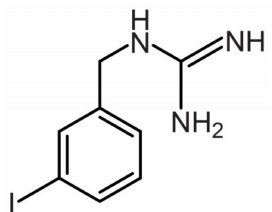
Figure 1. Molecular structure of